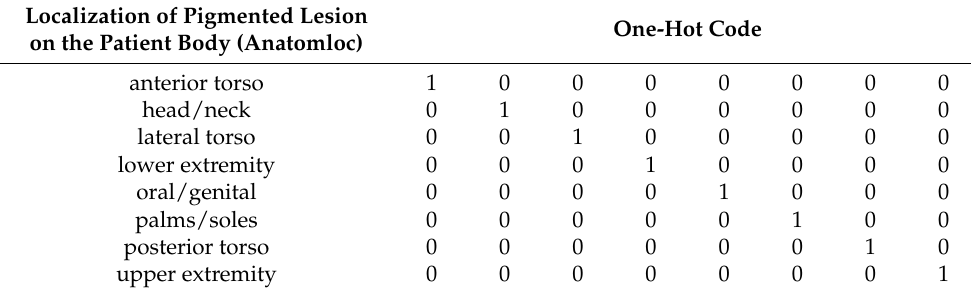
Table 2. A coding table for localization of pigmented lesion on the patient body.